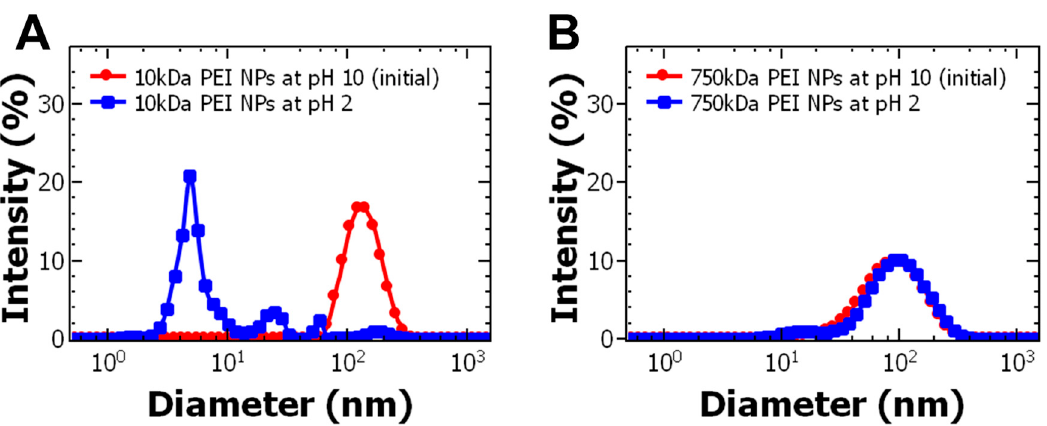
Figure 3. Effect of nanoparticle dispersion pH on size for ( A ) 10 kDa polyethylenimine nanoparticles (PEI NPs) and ( B ) 750 kDa PEI NPs. The size of the particles was measured 24 h after adjusting the pH. The 10 kDa PEI NPs destabilized under acidic conditions and released bovine serum albumin (BSA). The 750 kDa PEI NPs did not change size at acidic pH.